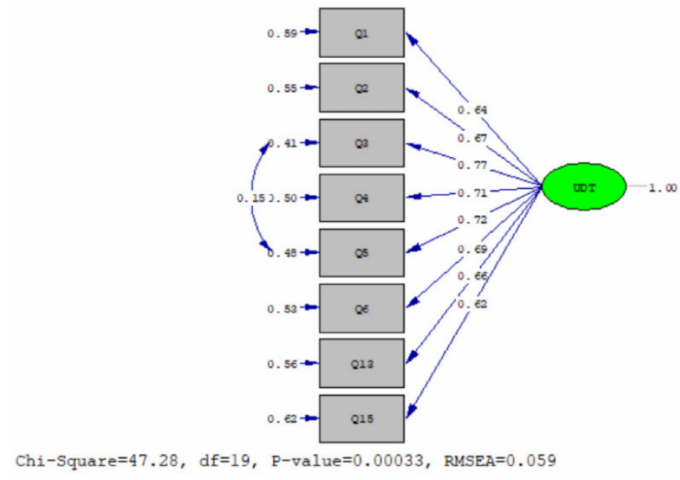
Figure 7. Alternative Model 4 (Final